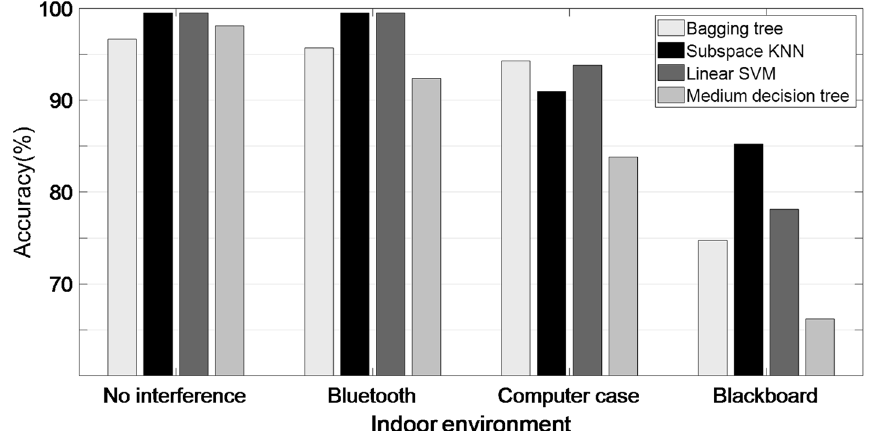
Fig. 15 Impact of the indoor